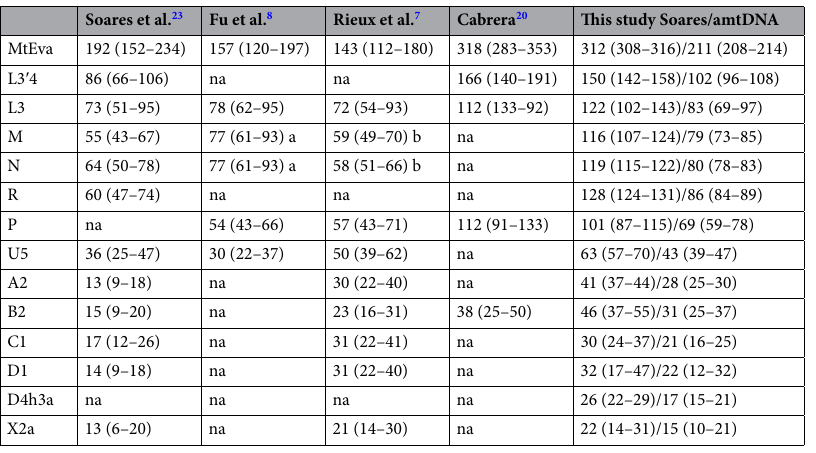
Table 3. Coalescence ages in thousand years for some major events in human history